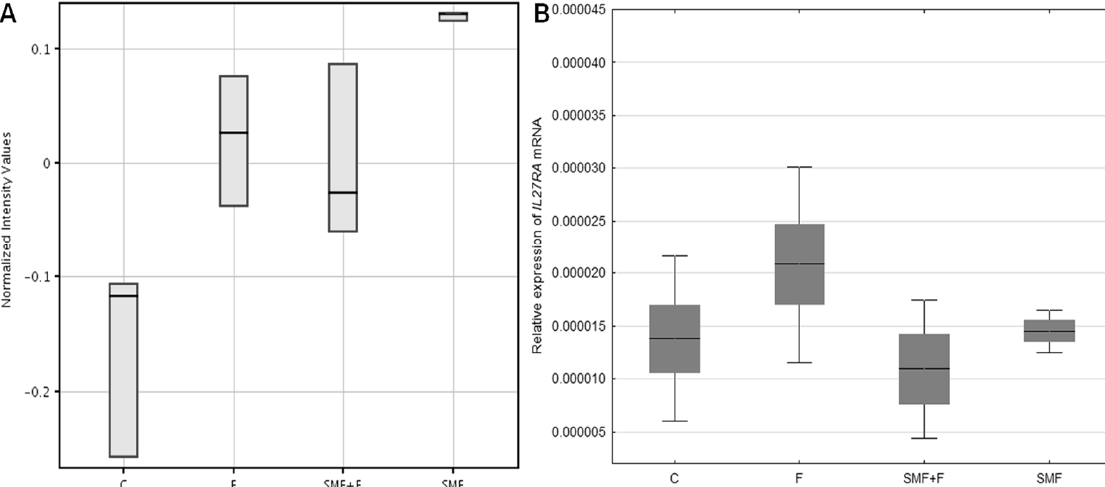
Figure 1. Expression of the IL27RA gene in control cells (C), F − -treated cells (F), cells that had been exposed to a static magnetic field (SMF), and cells that had simultaneously been exposed to a static magnetic field and F − (SMF + F) that was determined using the oligonucleotide microarray technique ( A ) and the RT-qPCR technique ( B ). The results are presented as the mean ± SE (box) and SD (whisker).